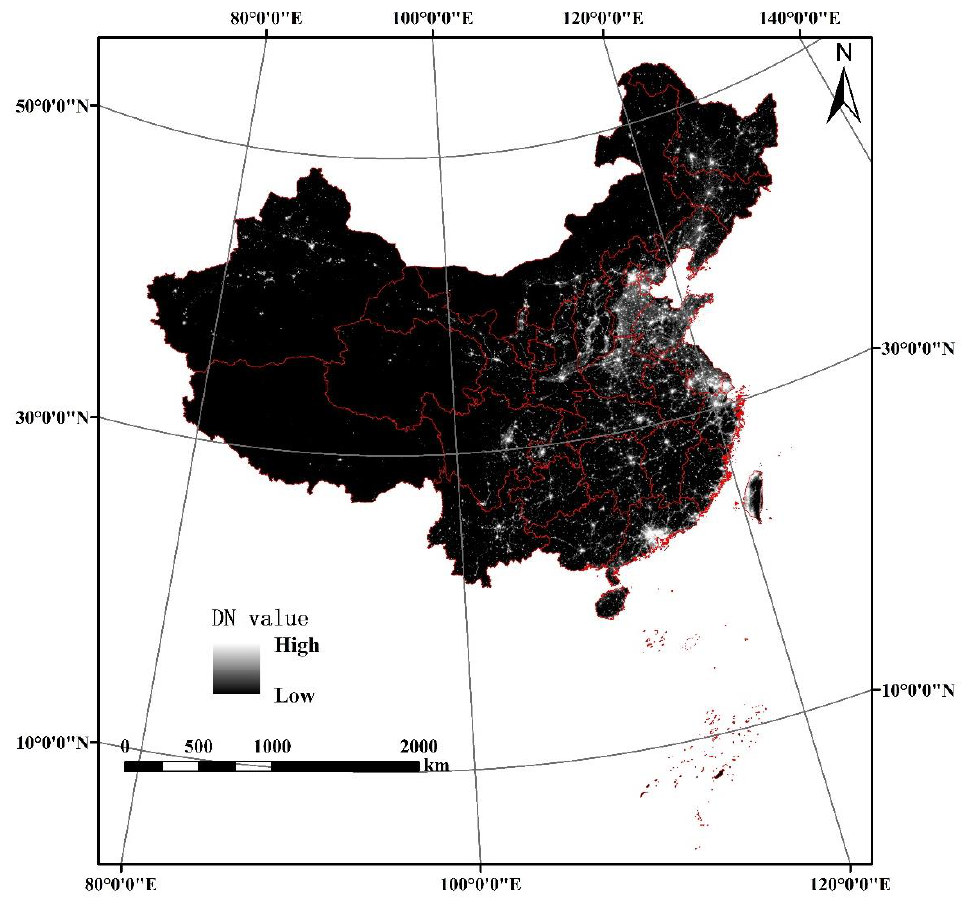
Figure 1. The geographical location of the study area.